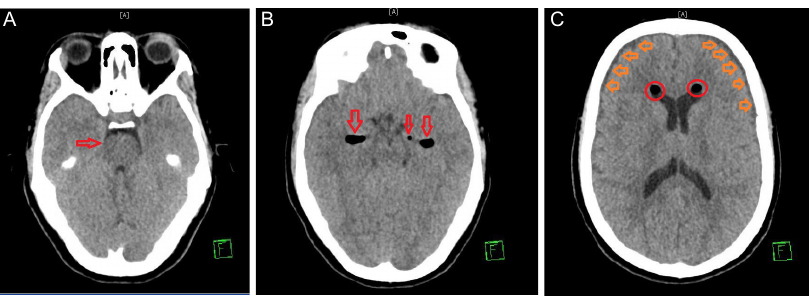
Figure 1. (A) CT brain showed subtle effacement of basal cistern (red arrow). (B) CT brain showed Intraventricular pneumocephalus (red arrows). (C). Intraventricular pneumocephalus (red circles) and bilateral mild frontoparietal subdural effusion (orange